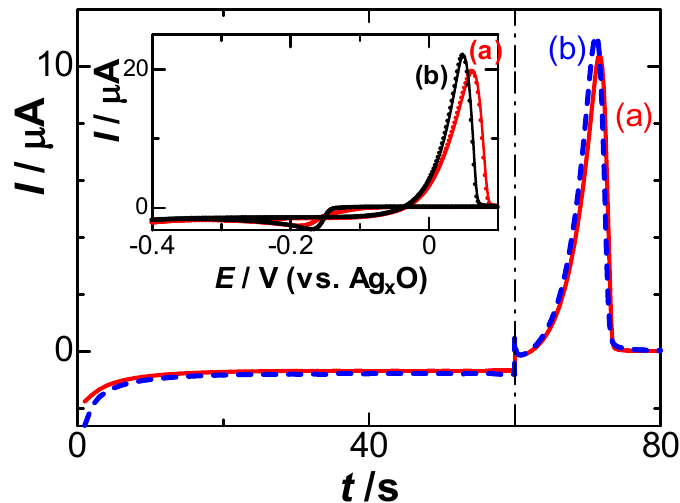
Figure 1. Current–time curves by a constant potential of − 0.25 V vs. Ag|Ag x O for the reduction and then by the anodic scan at v = 10 mV s −1 in a solution of 0.05 mM AgNO 3 including ( a ) 1 and ( b ) 500 mM NaNO 3 . The inset shows cyclic voltammograms.